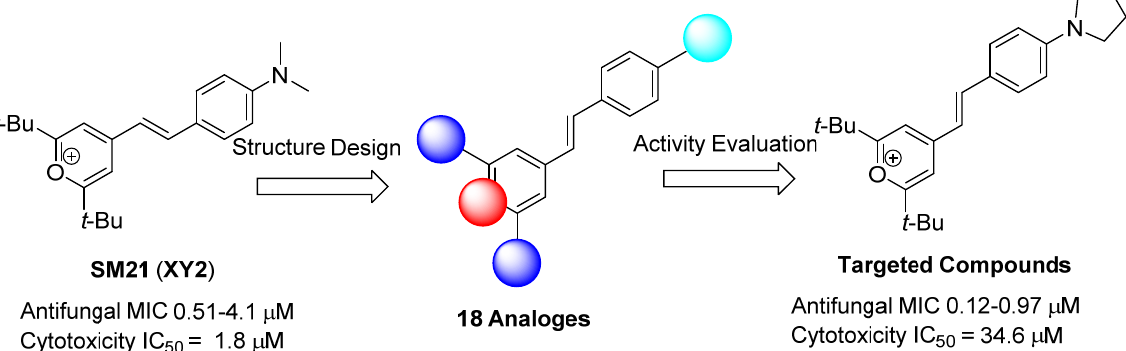
Figure 1. Design and evaluation of new antifungal agents based on lead compound SM21 ( XY2 ).